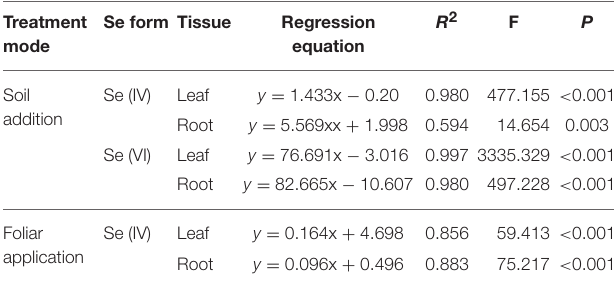
TABLE 2 | Results of regression analysis between exogenous Se treatment concentrations and Se accumulation concentrations in turnip leaves and roots. Treatment mode